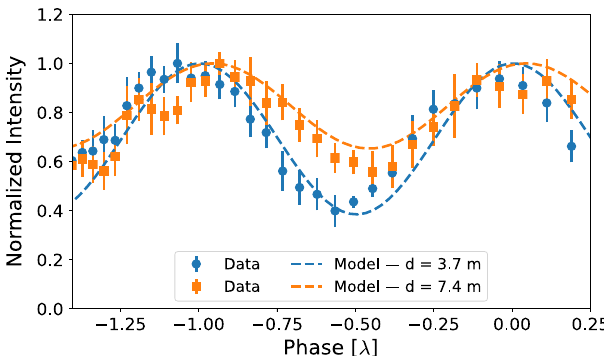
FIG. 10. Comparison between experimental data (points) and Gaussian propagation model prediction (dashed lines) for the scan of the phase between two sources in a non-XPU configu- ration (pure LV polarization). The distance d between the two sources has been varied by opening the fifth undulator sections (see Fig. 2). The blue curve corresponds to d ¼ 3 . 7 m while the orange one corresponds to d ¼ 7 . 4 m. Each experimental point is the average over 20 consecutive shots, the error bars are the standard